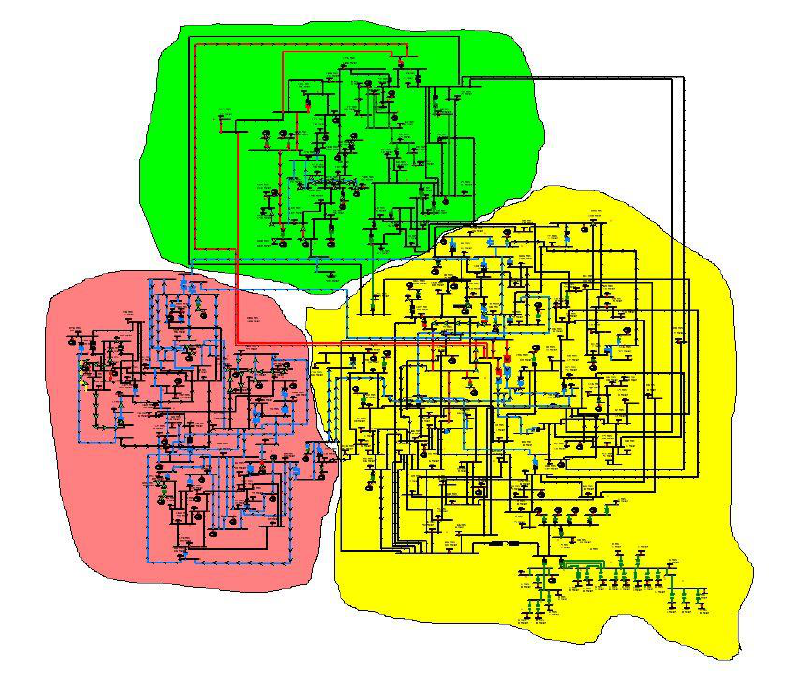
Figure 1. IEEE 300-Bus System case [18].